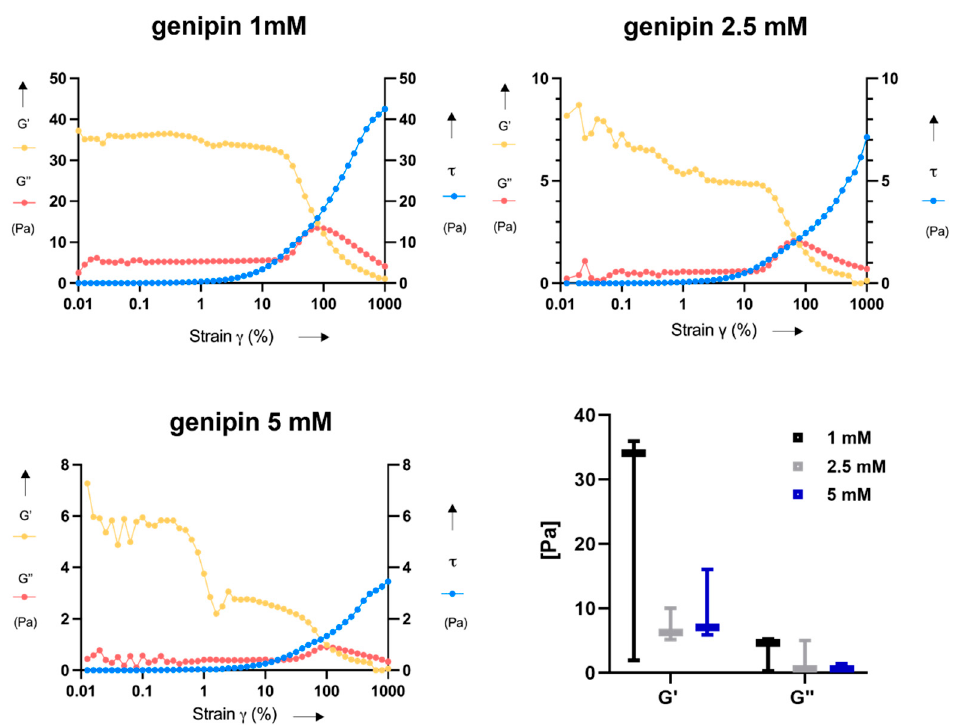
Figure 6. Results of rheometric measurements. Representative graphs of the trend of storage modulus (G’), loss modulus (G”), and shear stress ( τ ) versus the shear strain ( γ ) are reported for each genipin concentration. Boxplots with G’ and G” values, calculated in the linear region of the curves, are also reported for all samples at the three genipin concentrations.